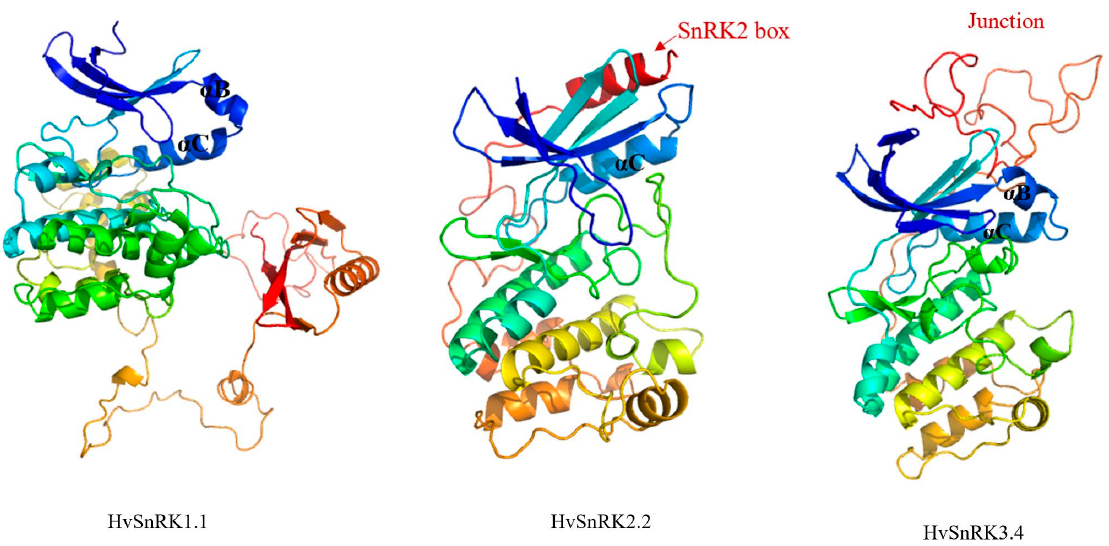
Figure 3. The 3D structure modeling of HvSnRK proteins. The pymol software was used to create the structural image.